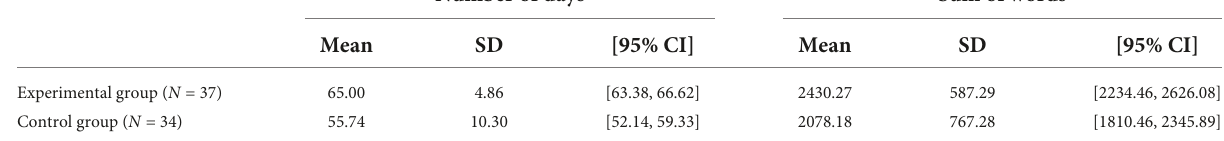
TABLE 2 Participants’ vocabulary learning log data.